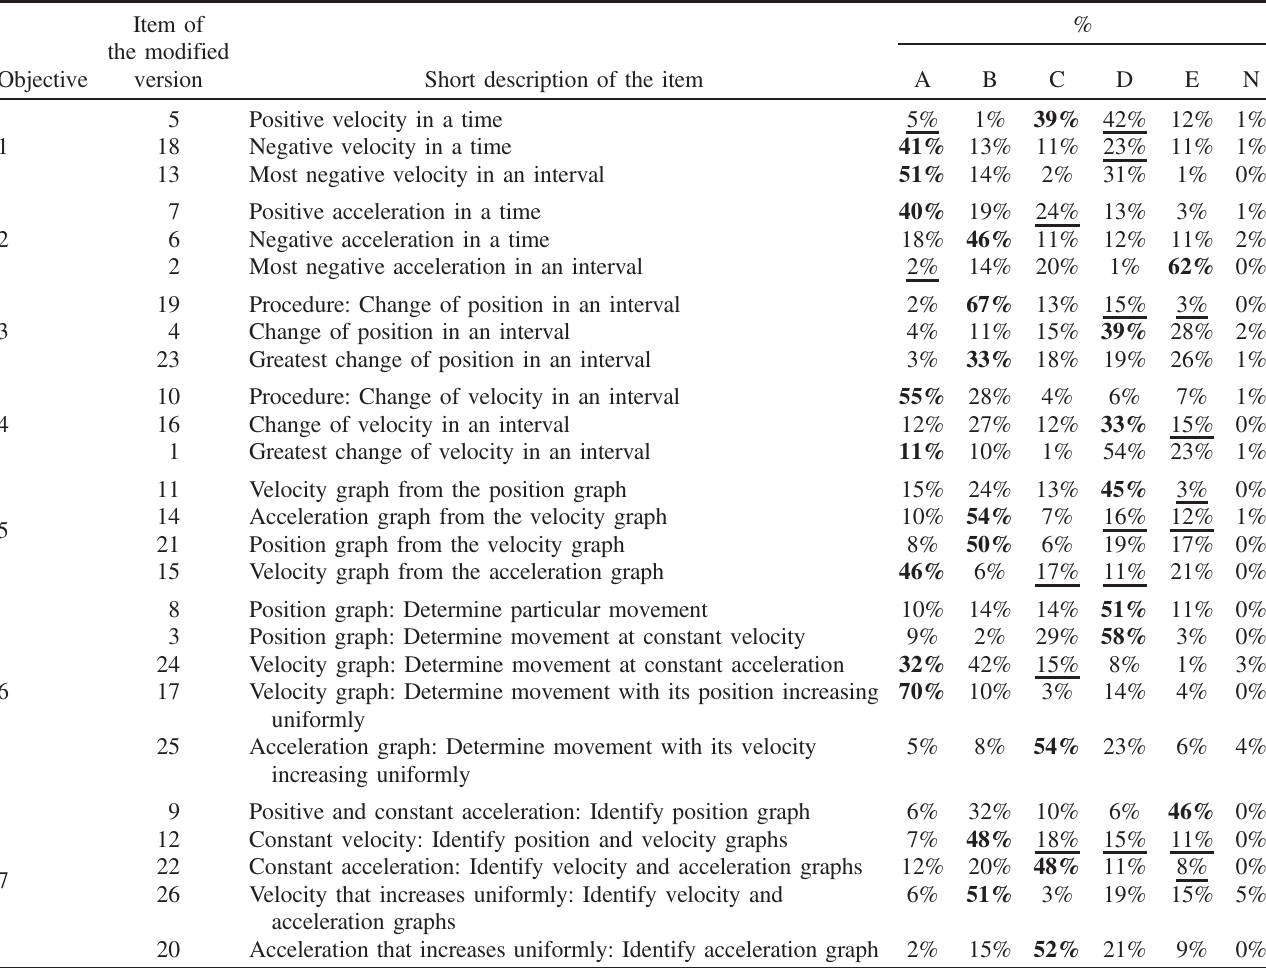
TABLE XI. Results obtained with items of the modified version organized by the seven objectives. Correct answers in bold. Note that the 18 added distractors with important changes are